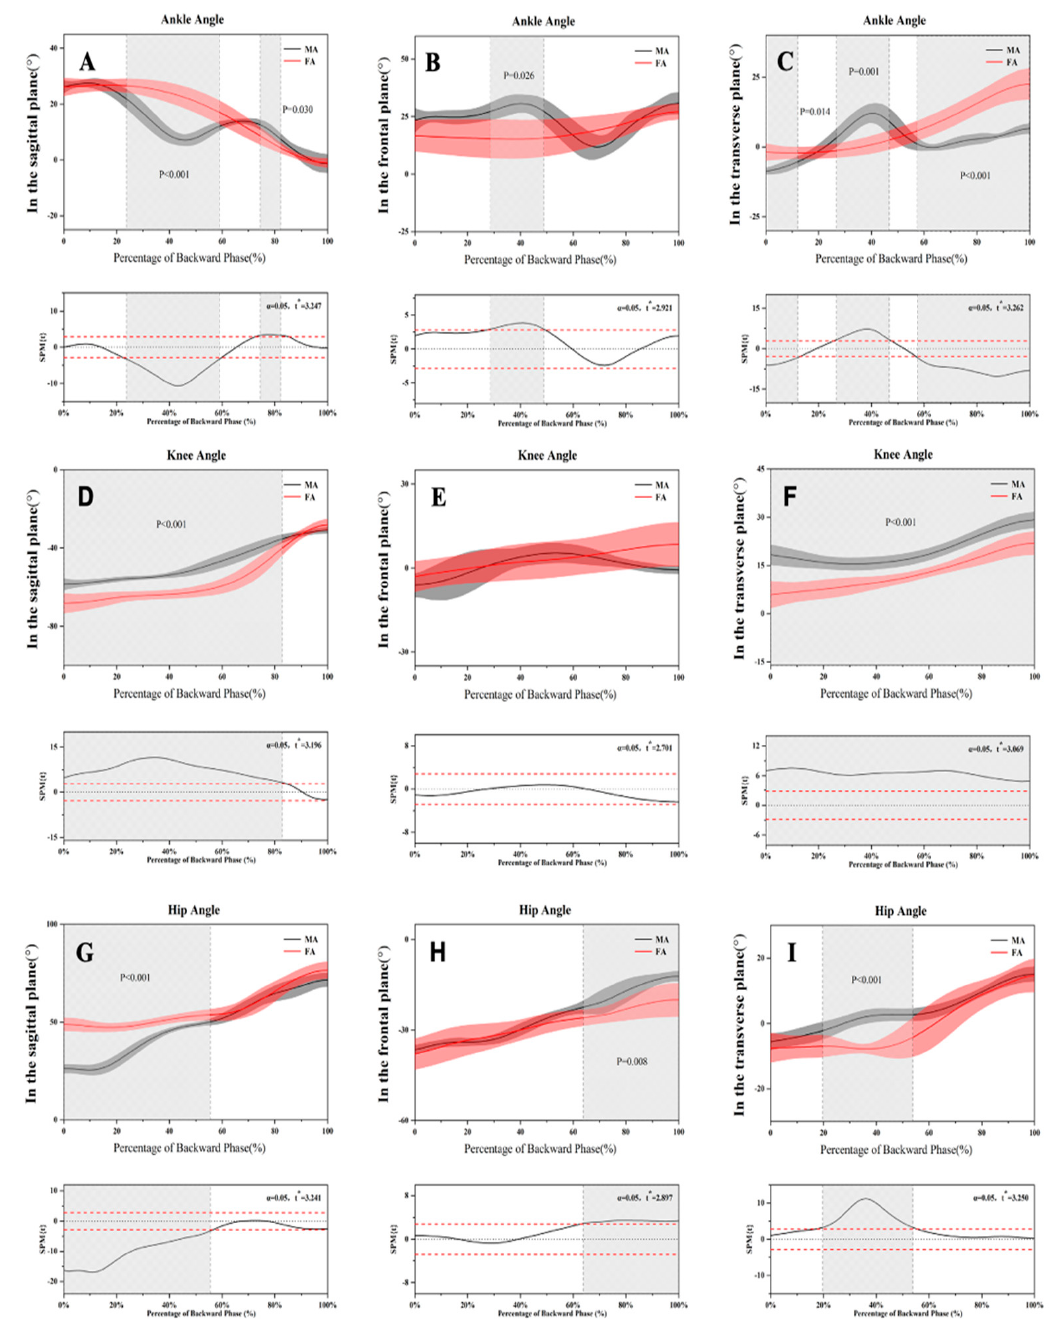
Figure 3. Changes of the lower limb joint angles during the backward phase in three planes. ( A – C ) Ankle angle changes during the BP in three planes. ( D – F ) Knee angle changes during the BP in three planes. ( G – I ) Hip angle changes during the BP in three planes.